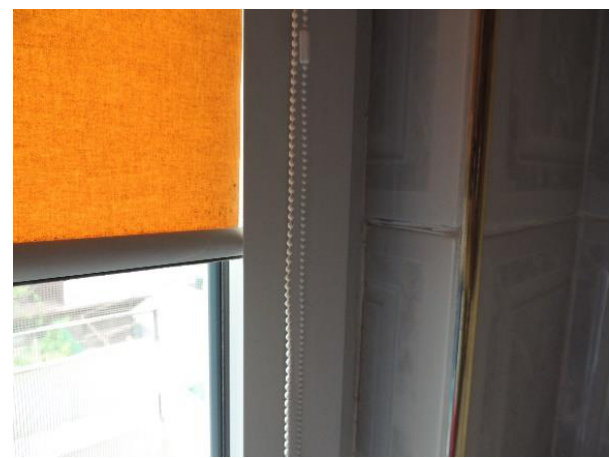
Fig. 3. Mushroom on building equipment (own